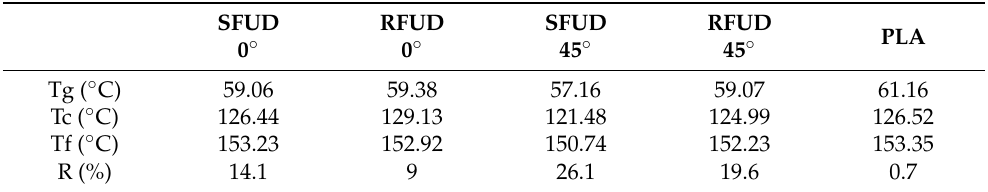
Table 3. Condensed results of DSC tests on the different composite configurations investigated (SF: sorted fibers, RF: raw fibers).